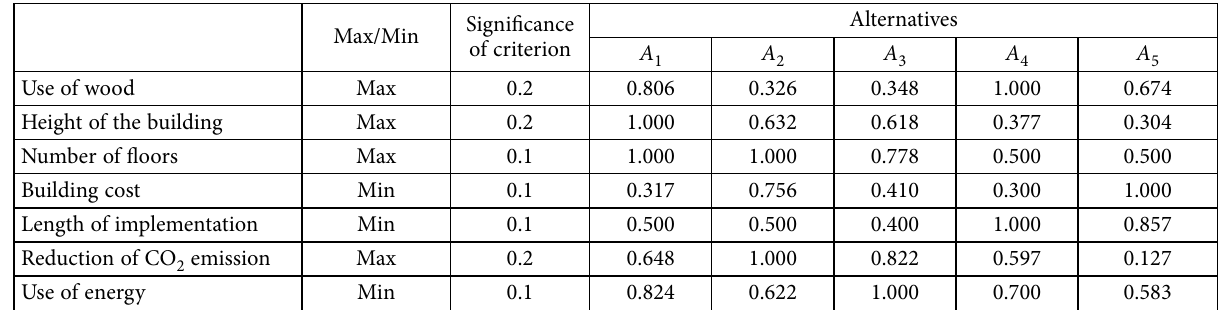
Table 3. Decision-making matrix after